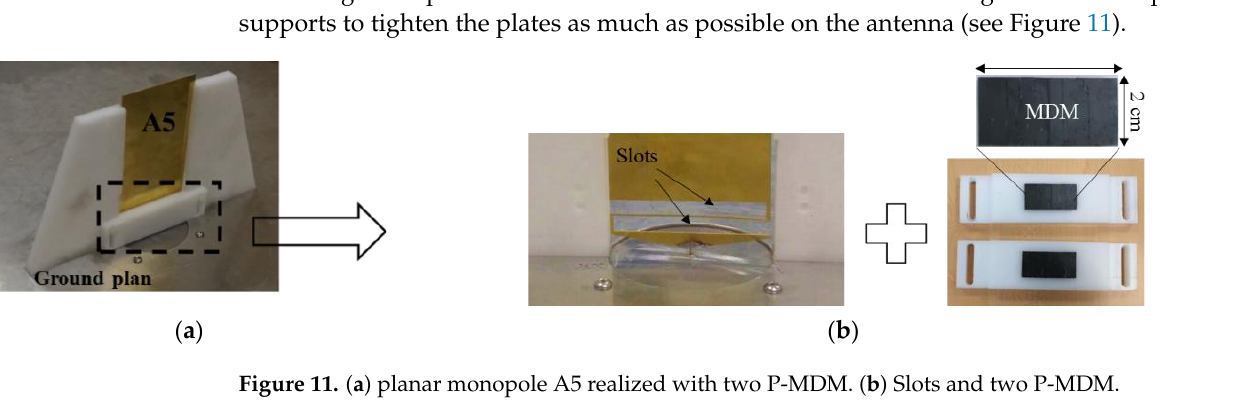
Figure 11. ( a ) planar monopole A5 realized with two P-MDM. ( b ) Slots and two P-MDM.